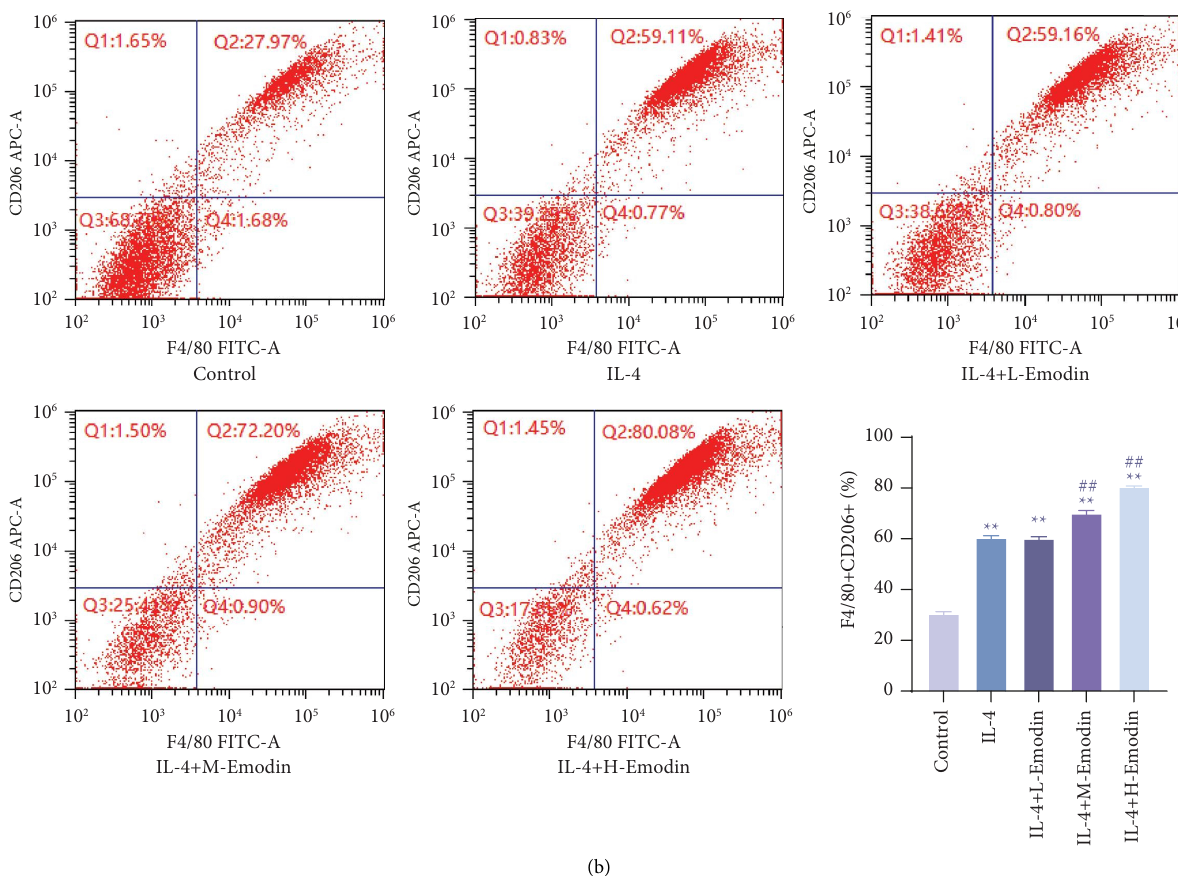
Figure 3: Emodin efects on the polarization of macrophages were detected by fow cytometry ( n � 3). (a) Emodin inhibits LPS-induced polarization of M1 macrophages; (b) Emodin promotes IL-4-induced polarization of M2 macrophages. ∗∗ P < 0 . 01 vs. control; ## P < 0 . 01 vs. IL-4 or